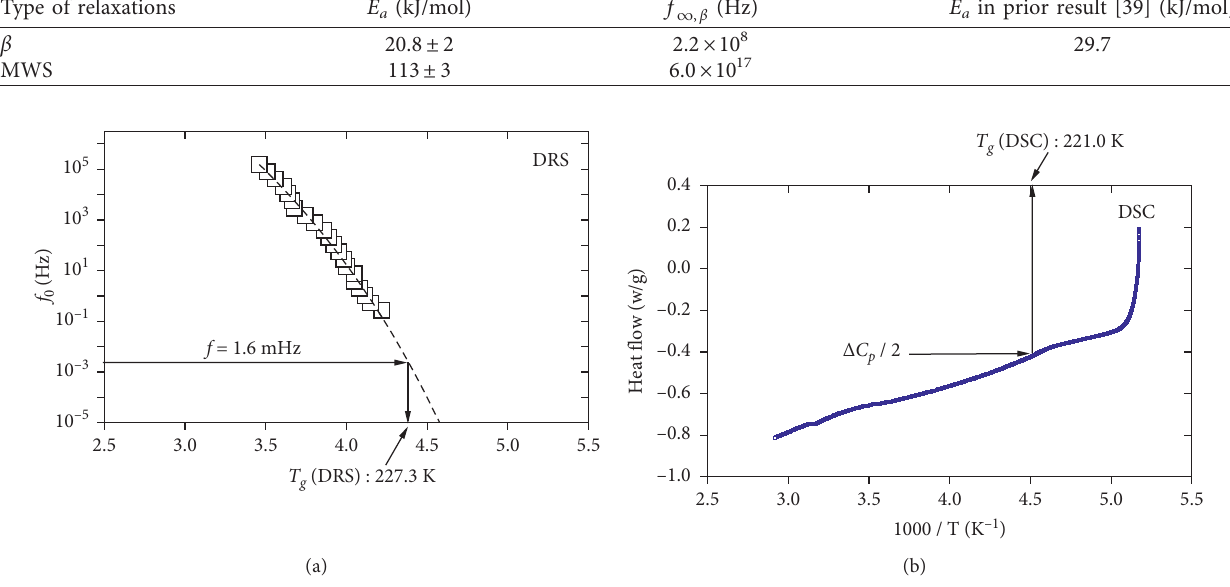
Figure 15: (a) the glass transition temperature determined by DRS and (b) the glass transition temperature determined by DSC. Table 8: The dipole moment calculated for a specific monomer in EPDM. Type of